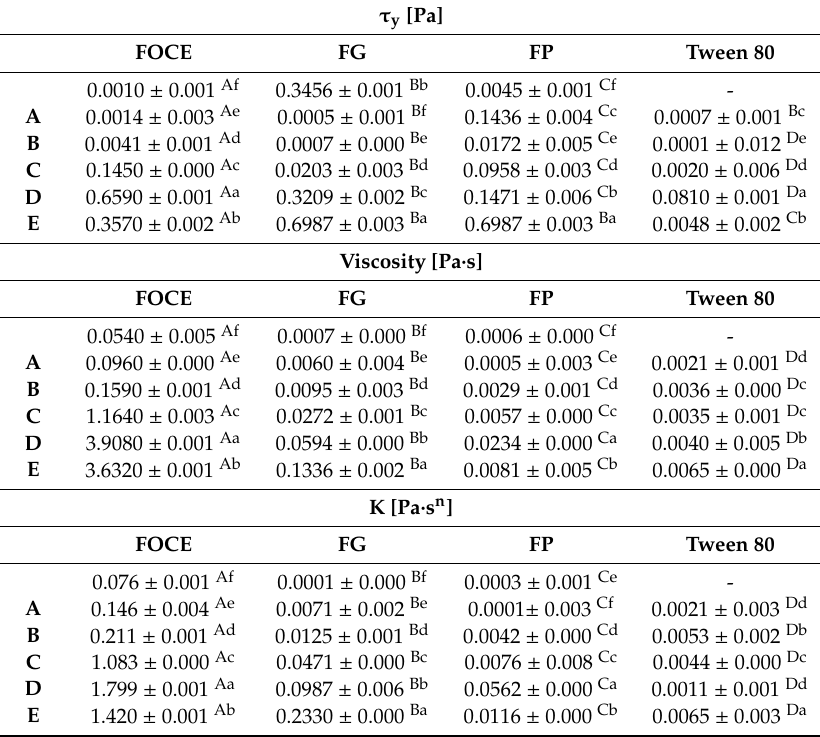
Table 3. Rheological parameters of samples based on Herschel–Bulkley